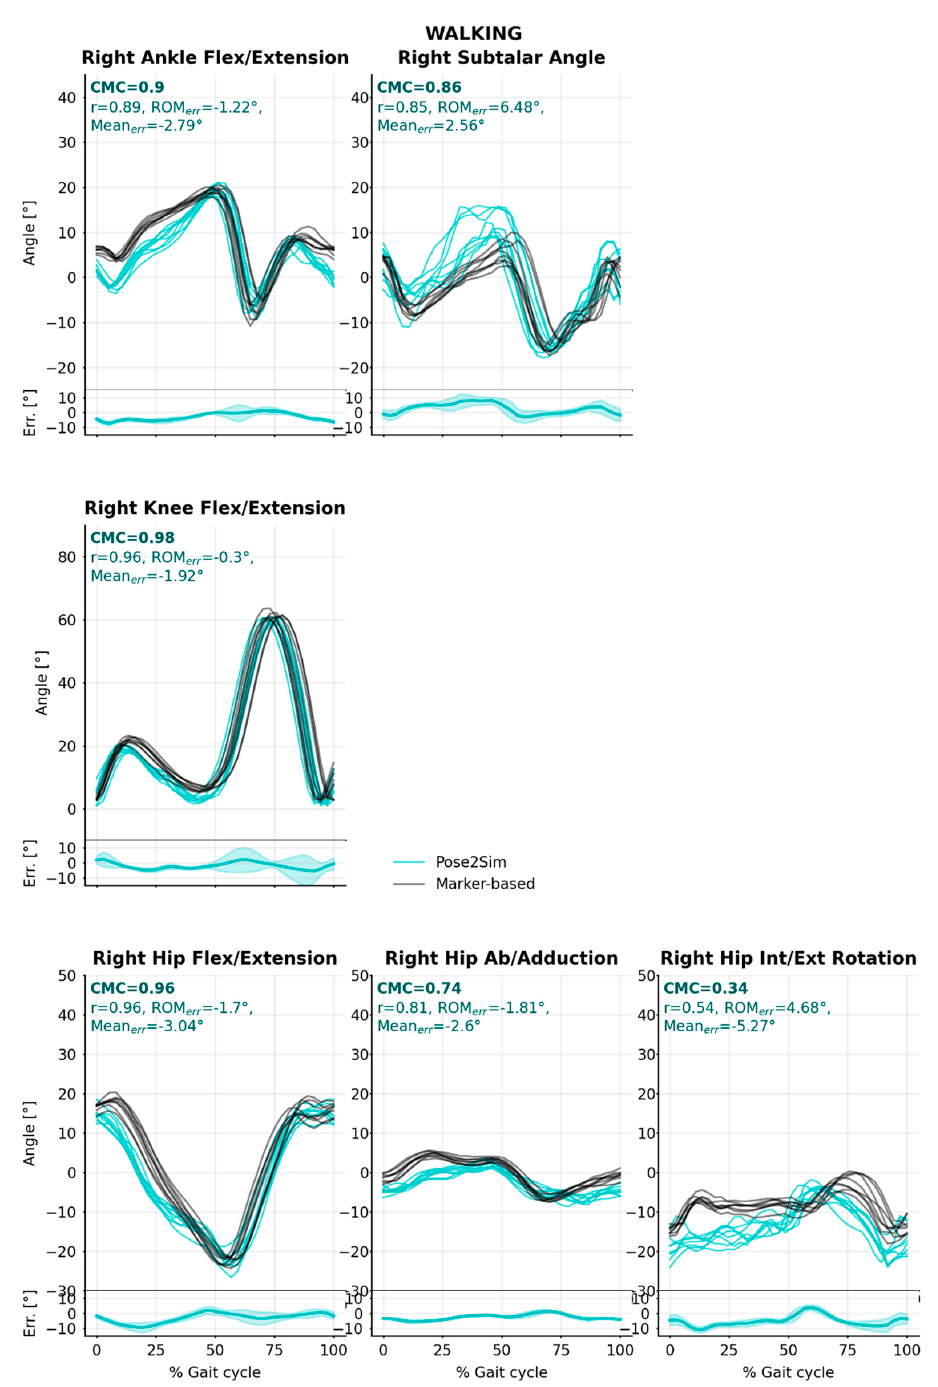
Figure 4. Pose2Sim (cyan) and marker-based (black) lower-body joint angles for the walking task. Coefficient of multiple correlation (CMC) is indicated, and broken down into, respectively, Pearson’s coefficient (r) for correlation assessment, range of motion errors (ROM err ) for gain, and overall mean errors (Mean err ) for offset. Mean error and standard deviations are also represented at the bottom of the graphics. See Appendix A for running and cycling results, and for sacro-lumbar and upper-body results.